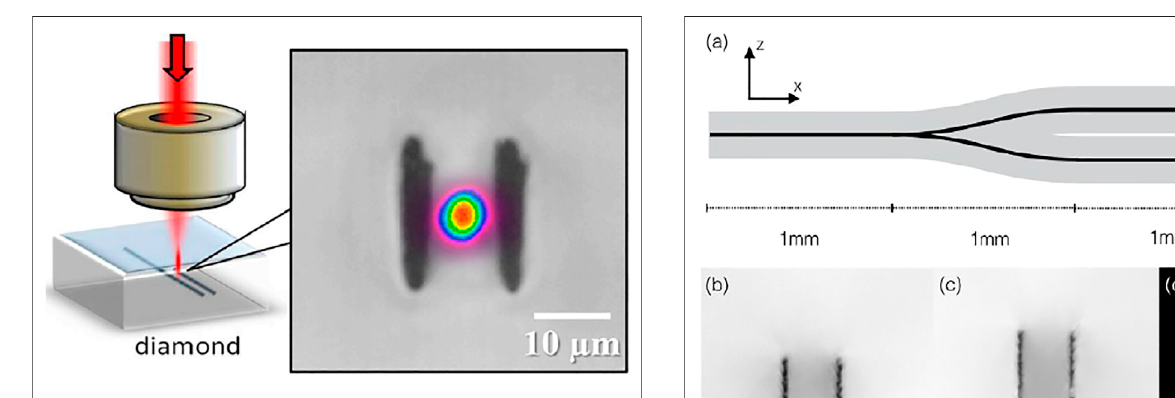
FIGURE 8 | Type II waveguide geometry and transverse view optical microscope image of type II modi fi cation in diamond. Creative Commons Attribution License [54].